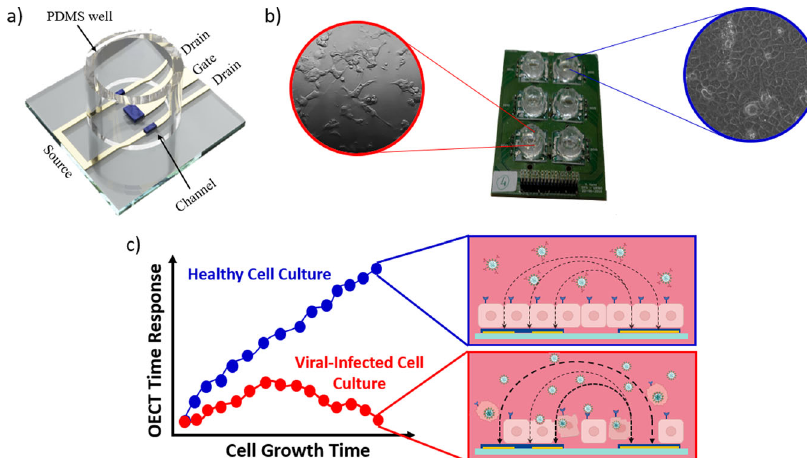
Fig. 1 OECT and TECH-OECT representations including viral activity schematic on the cell line. a Rendering of the planar Organic Electrochemical Transistor, consisting in a glass substrate with Cr/Au contacts and Pedot:Pss channels and gate, enclosed in a PDMS perforated cylinder to implement the culture well. b TECH-OECT with six devices inserted and electrically connected. Optical zooms highlight a viral-infected (red) and a healthy cell line (blu) after 48 h from seeding. Circle diameter of 500 μ m. c Schematical graph (left) of the expected OECT responses discriminating a viral-infected culture and a healthy one, with the relative cross-section representations (right). Black arrows represent ionic fl uxes across cell layers, which intensify upon layer destruction caused by viral